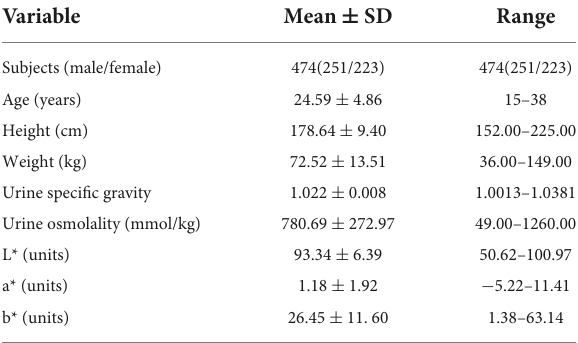
TABLE 1 Participants and urine sample characteristics.